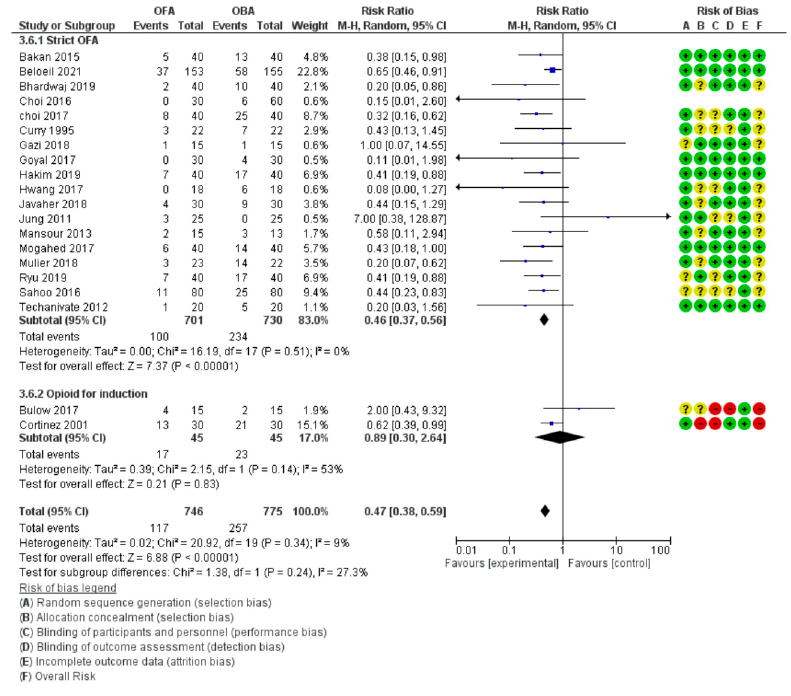
Figure 3. Forest plot for nausea and vomiting in the